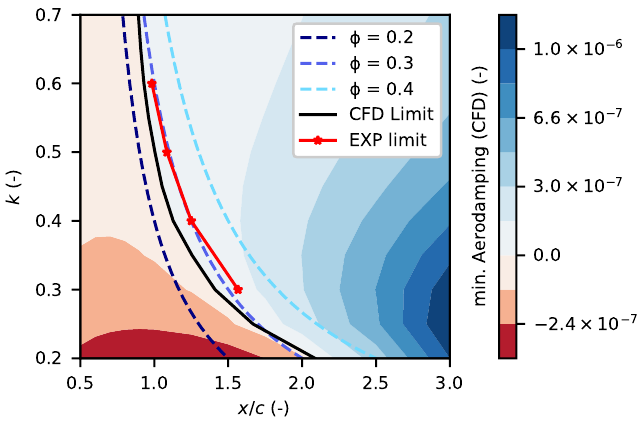
Figure 17. Stability map with contours of minimum aerodamping (CFD) as a function of k and x / c